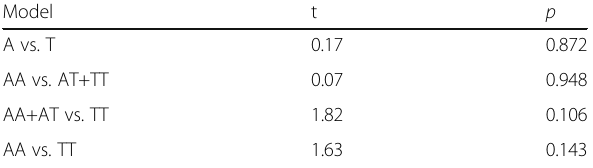
Table 2 Detailed results of Egger ’ s test